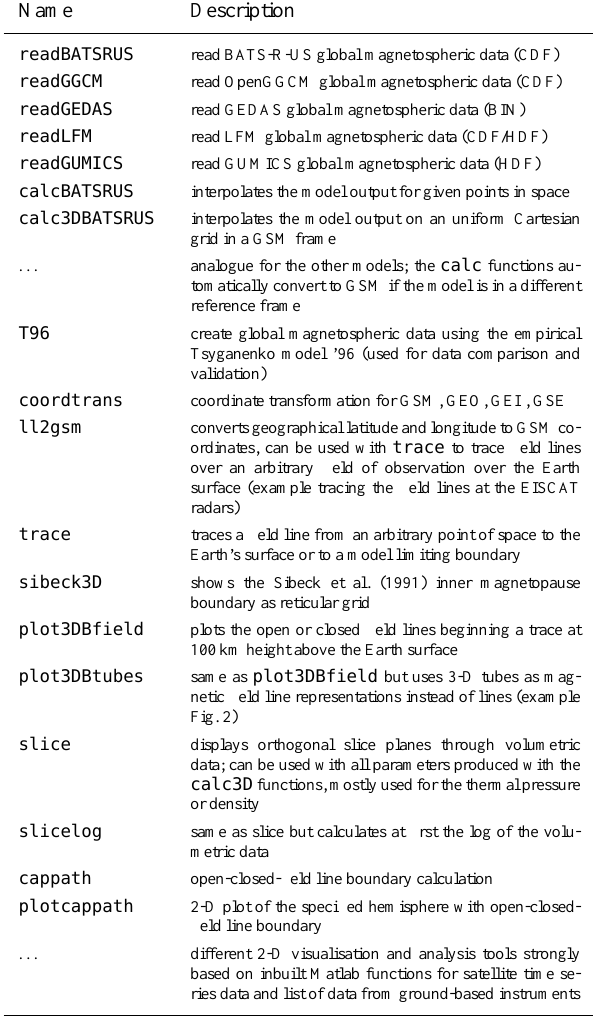
Table 1. VisAn MHD core and add on